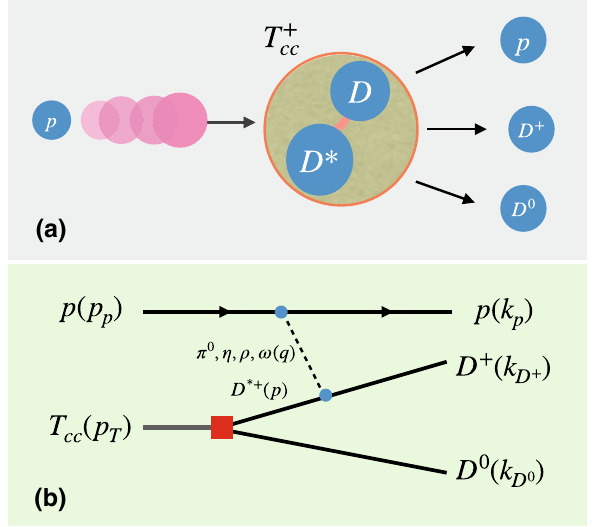
Fig. 1 The reaction of p + T + cc → p + D + + D 0 . a The sketch map of the reaction. b The Feynman diagram of the reaction, the denotations of the momenta of particles are also